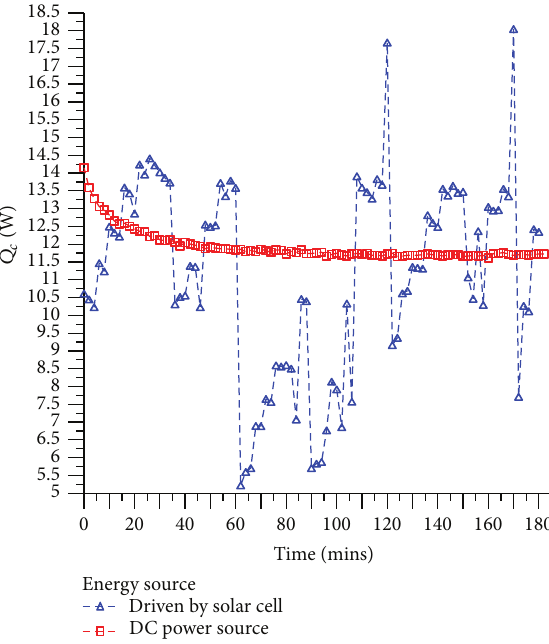
Figure 7: The cold side temperatures of the thermoelectric system by DC source and solar cells.